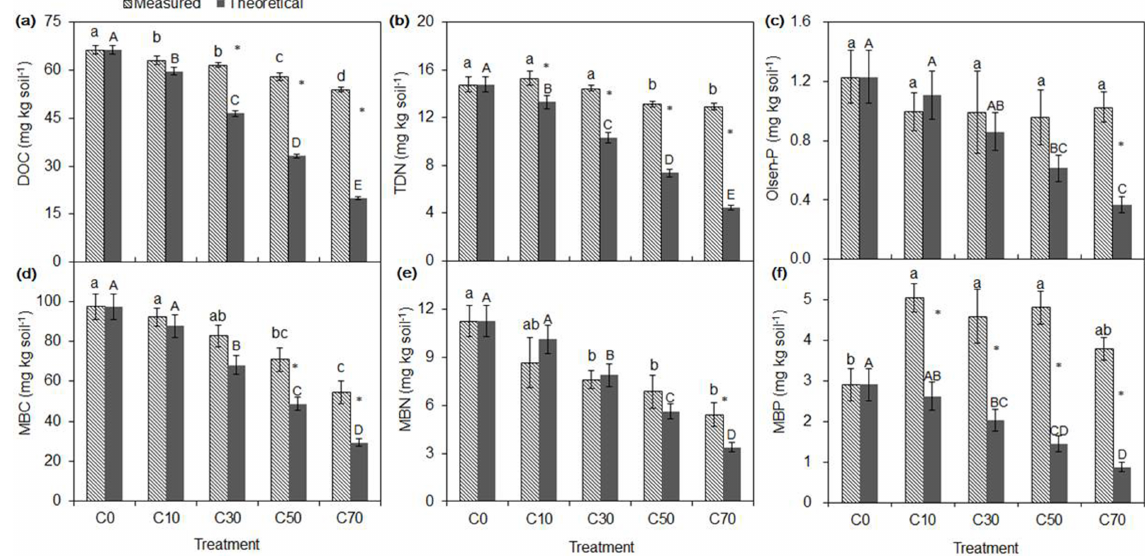
Figure 4. Changes in soil (a) dissolved organic carbon (DOC), (b) total dissolved nitrogen (TDN), (c) Olsen phosphorus (Olsen-P), (d) mi- crobial biomass carbon (MBC), (e) microbial biomass nitrogen (MBN), and (f) microbial biomass phosphorus (MBP) as affected by different degrees of soil coarseness: 0% sand addition (C0), 10 (C10), 30 (C30), 50 (C50), and 70% (C70). Dashed bars represent values obtained from laboratory measurements, while black bars are values calculated from theoretical dilution. Data represent mean ± standard error ( n = 6). Letters indicate significant differences among treatments. Asterisks indicate significance between values from laboratory measurements and theoretical values accounting for dilution within one